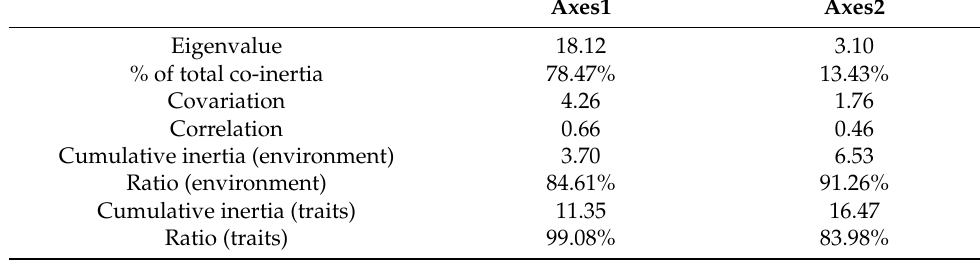
Table 3. Results of the RLQ analysis. Eigenvalues and the first two RLQ axes account for the percentage of total inertia; covariation is the covariance between the two new sets of factor scores projected onto the first two RLQ axes; correlation is the correlation between the two new sets of factor scores projected onto the first two RLQ axes. Cumulative inertia is the variance of each set of factor scores; ratio is the variance of the first RLQ axis as a percentage of the first axis analyzed separately. Axes1